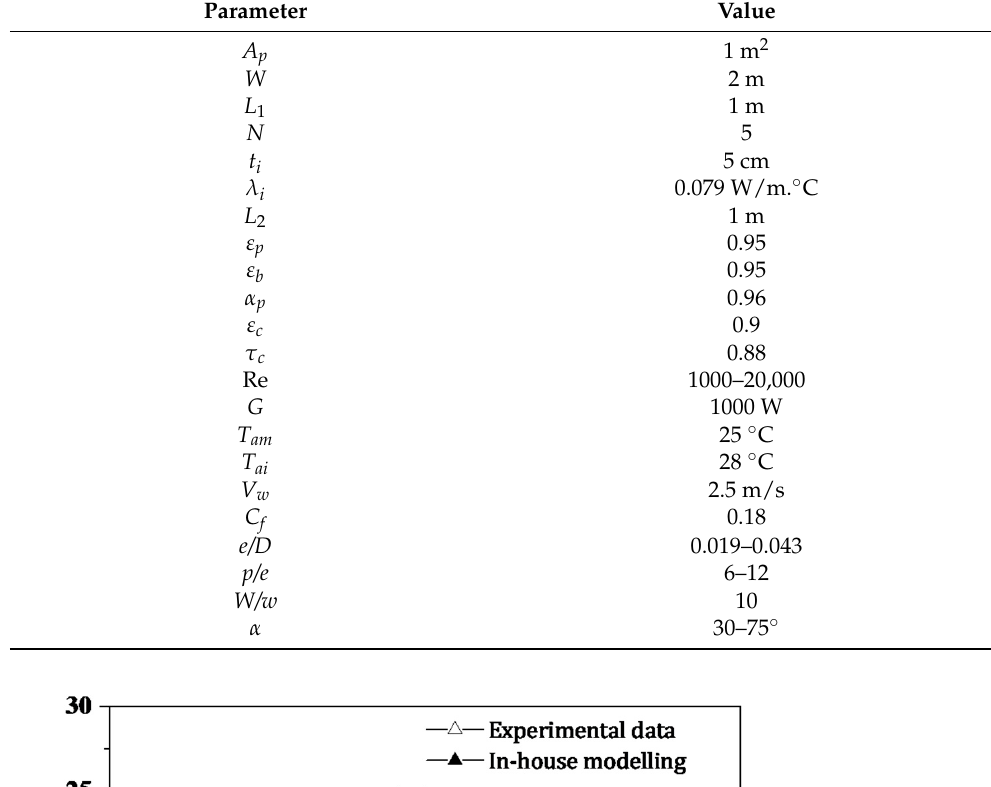
Table 1. Parameters used in our numerical solution.